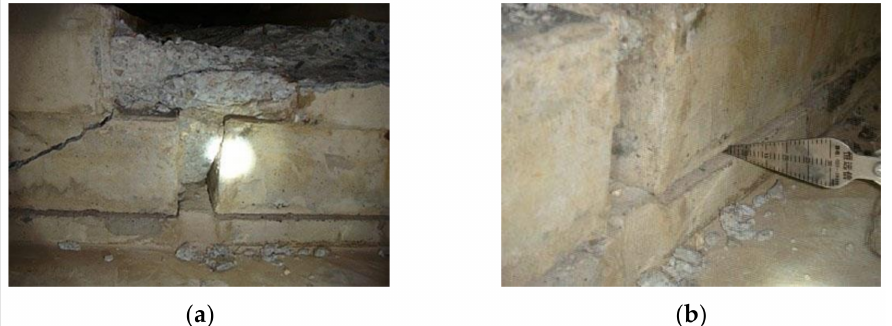
Figure 1. Track slab arcing of longitudinally connected ballastless track on bridge: ( a ) the shear failure of track slab; ( b ) the emptying of mortar